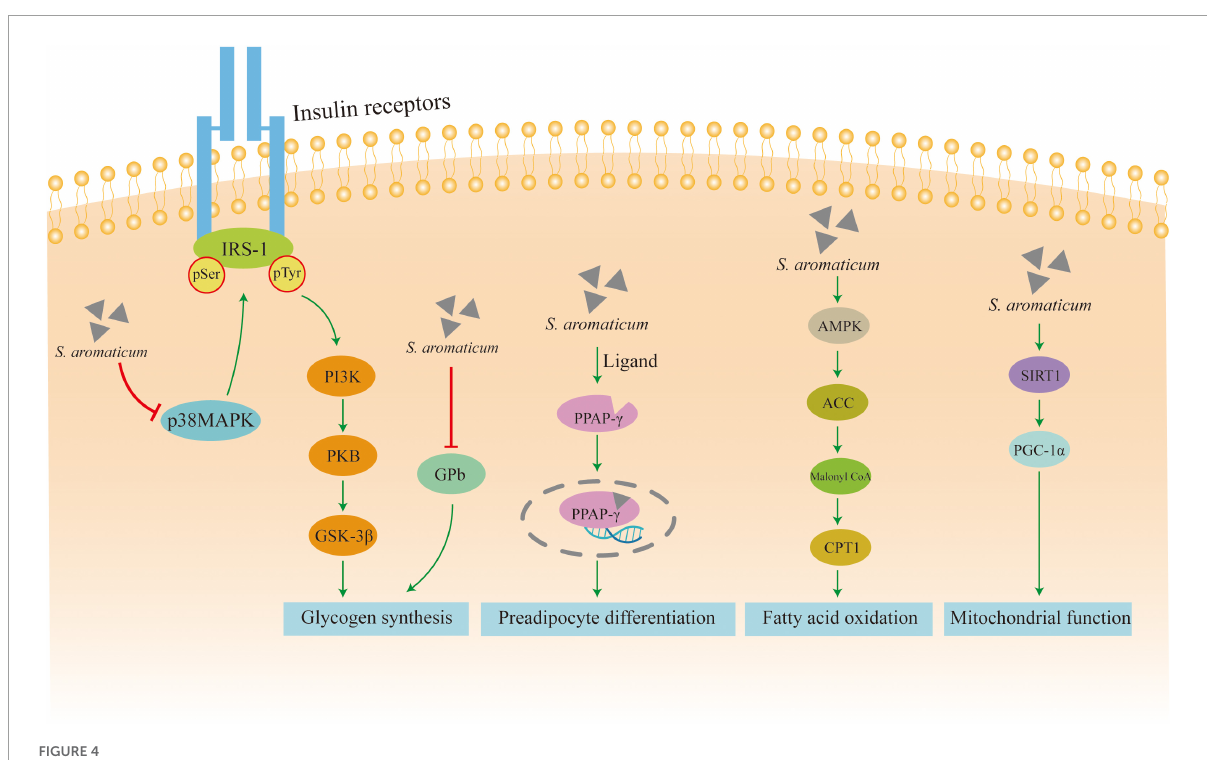
FIGURE4 Mechanism of action for the hypoglycemic